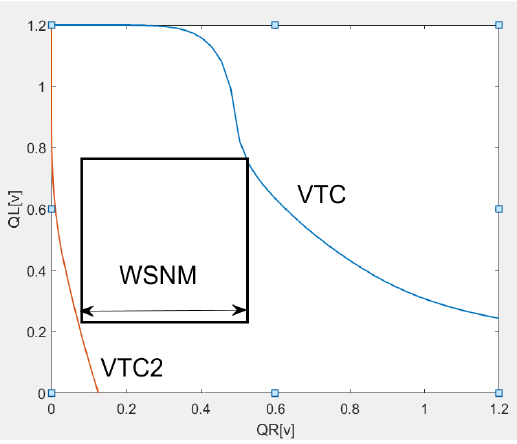
Figure 4. Static stability simulation diagram of the write operation.